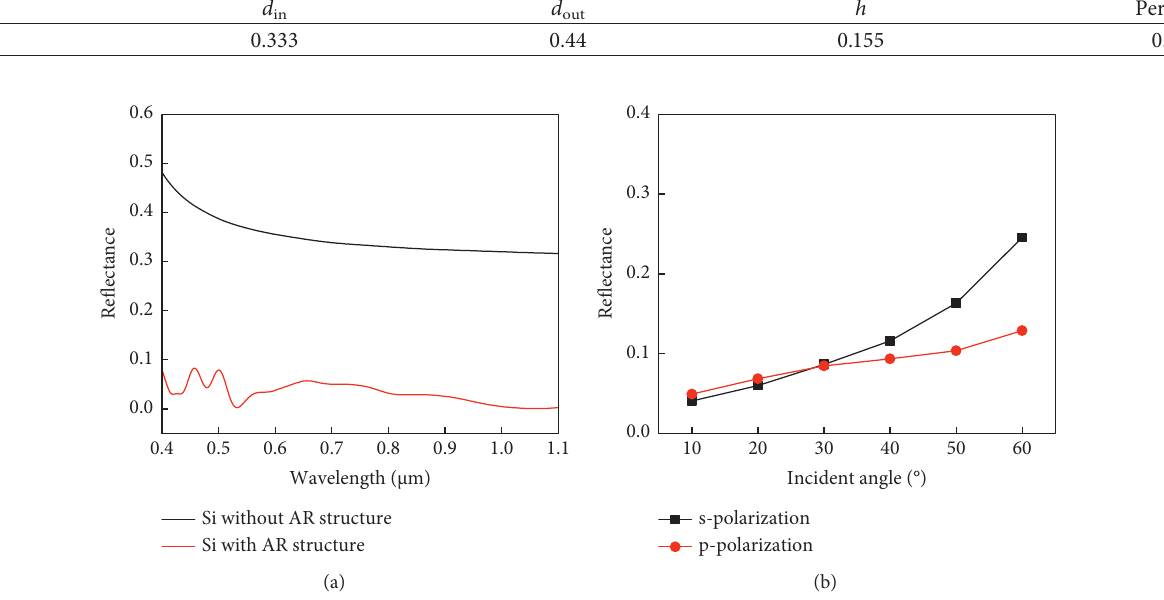
Figure 2: (a) Reflectance spectra of the silicon substrate with and without AR subwavelength structures under normal incidence. (b) Reflectance for s-polarized (black curve with solid square symbols) and p-polarized (red curve with solid dot symbols) incident beam over the angle of incidence (AOI) from 10 ° to 60 ° .